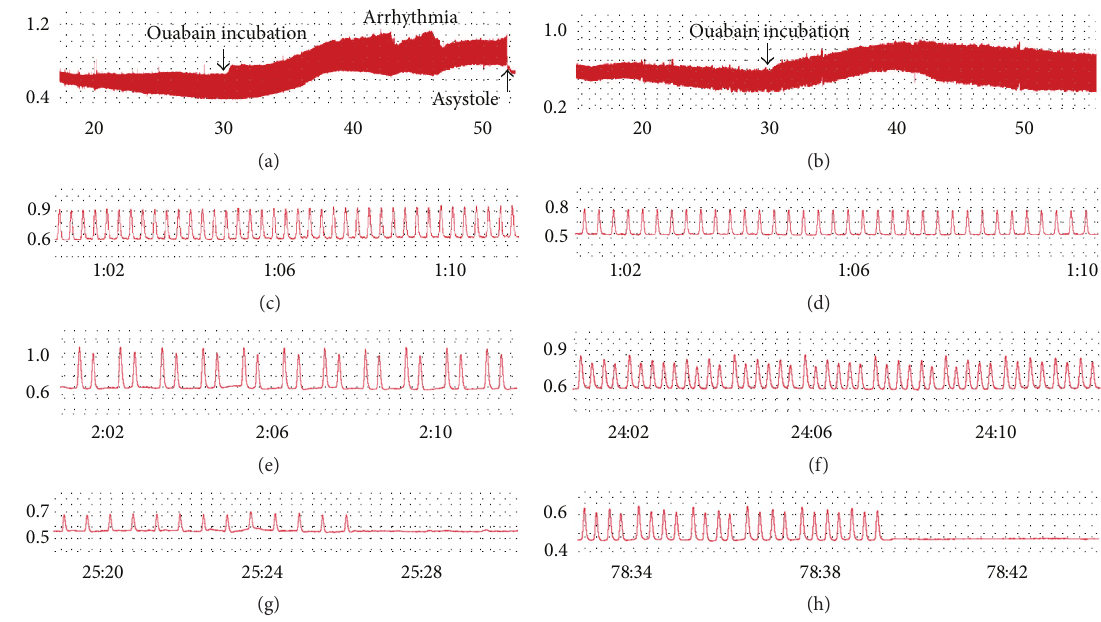
Figure 4: A general comparison in chronotropic and inotropic features between vehicle- and clofibrate-treated groups. Complete records of isolated atrial beats of vehicle-treated (a) and clofibrate-treated (b) groups. In vehicle-treated group (a), ouabain-induced arrhythmia is obvious and asystole happens after arrhythmia. The severity of arrhythmia in clofibrate-treated group is lesser and, in some samples (b), no asystole was seen until several hours. Atrial beatings before incubation of ouabain in vehicle-treated (c) and clofibrate-treated (d) groups. As shown, atrial beatings and contractile force are similar in both groups. Ouabain-induced arrhythmia in vehicle-treated (e) and clofibrate-treated (f) groups. The shape of arrhythmia in vehicle-treated group is bigeminy (twin spikes with strong force), which is the typical manifestation of ouabain-induced arrhythmia (a). In clofibrate-treated group (b), spikes of arrhythmia are weak and irregular, and it happens much later than vehicle-treated group. Ouabain-induced asystole in vehicle-treated (g) and clofibrate-treated (h) groups. Time of onset of asystole in clofibrate-treated group (h) is later than vehicle-treated